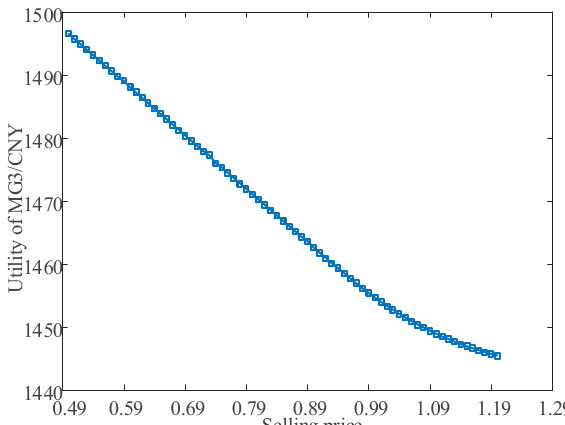
Figure 14. The utility of MG3 response to internal selling prices. ( 14 Figure A2. The utility of MG3 response to internal selling prices. ( k 14 = − 30, p 14 = 0.49, p 14 = 0.35, p 14 = 1.189). 172.7, e 14 gs 3 cb gb